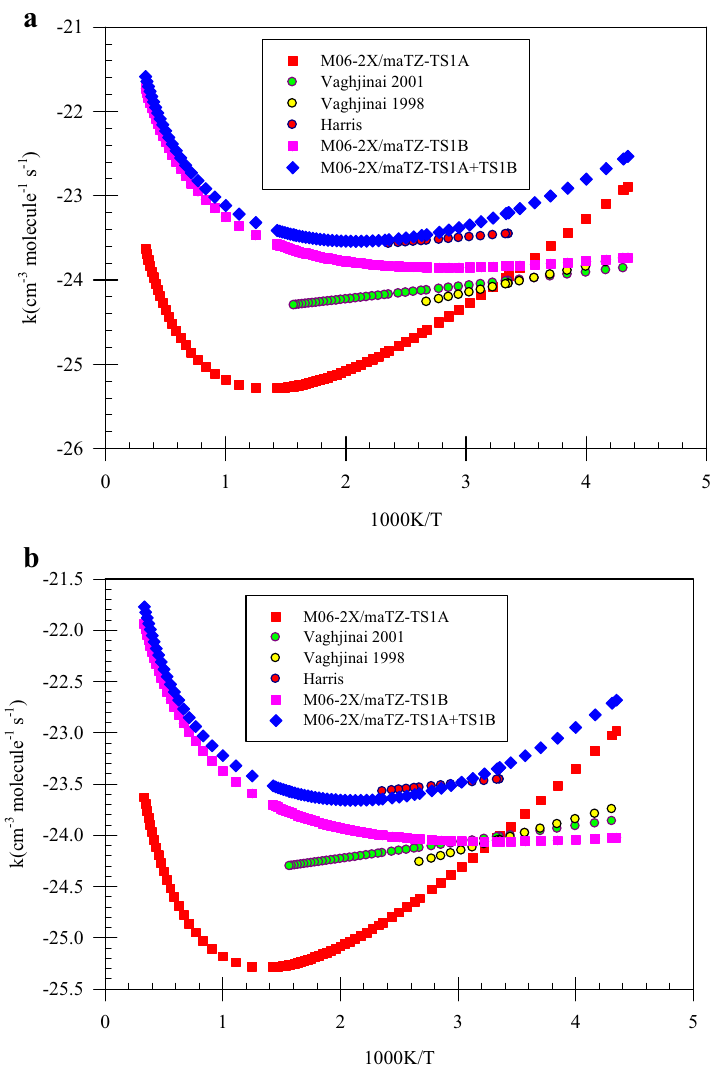
Figure 3. Representation of Arrhenius plot for P1 production pathways computed at the M06-2X/maTZ level : ( a ) TST theory ( b ) VTST